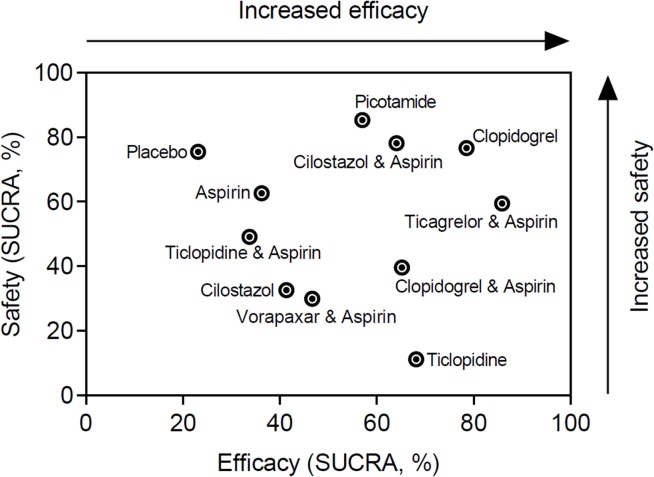
Benefit-harm profile of different antiplatelet agents.Two-dimensional ranking of antiplatelet agents according to safety (y axis) and efficacy (x axis) based on the cumulative rank probabilities (SUCRA; %). The top right corner denotes therapies with the most favourable benefit-harm profile (safe and effective).